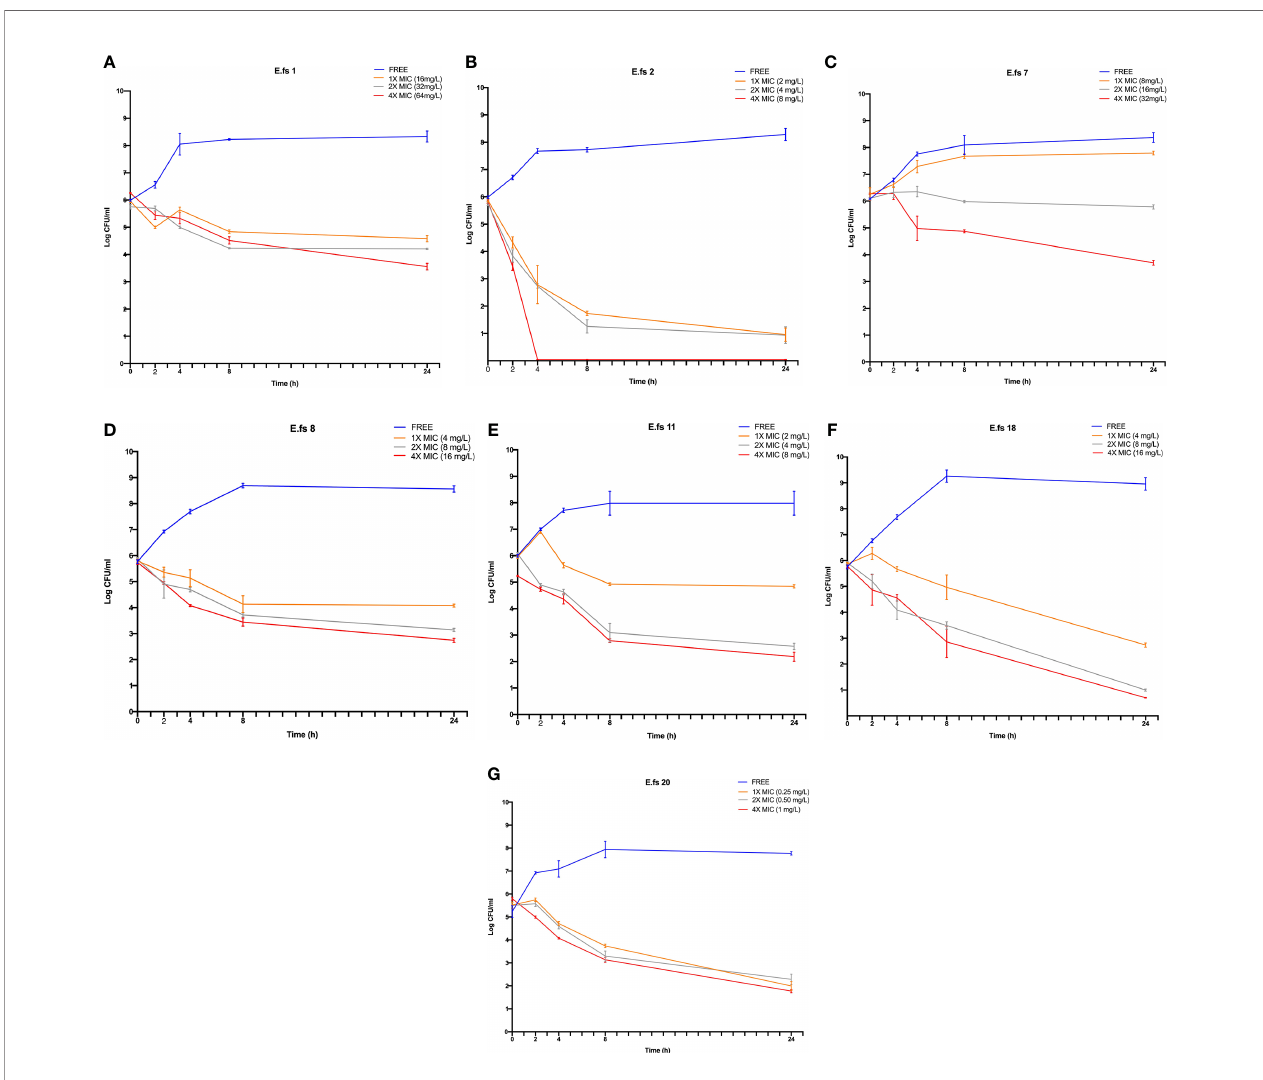
FIGURE 1 | Time-kill assays of ceftobiprole (BPR) against the seven E. faecalis clinical isolates in study. Cell count was reported as log 10 (CFU/ml) at 0, 2, 4, 8 and 24h Time-points (T0, T2, T4, T24); Ceftobiprole (BPR) exposure was tested at 1X, 2X and 4X MICs. Error bars represent standard deviations (±SD) of the mean of triplicate experiments (A – G) .